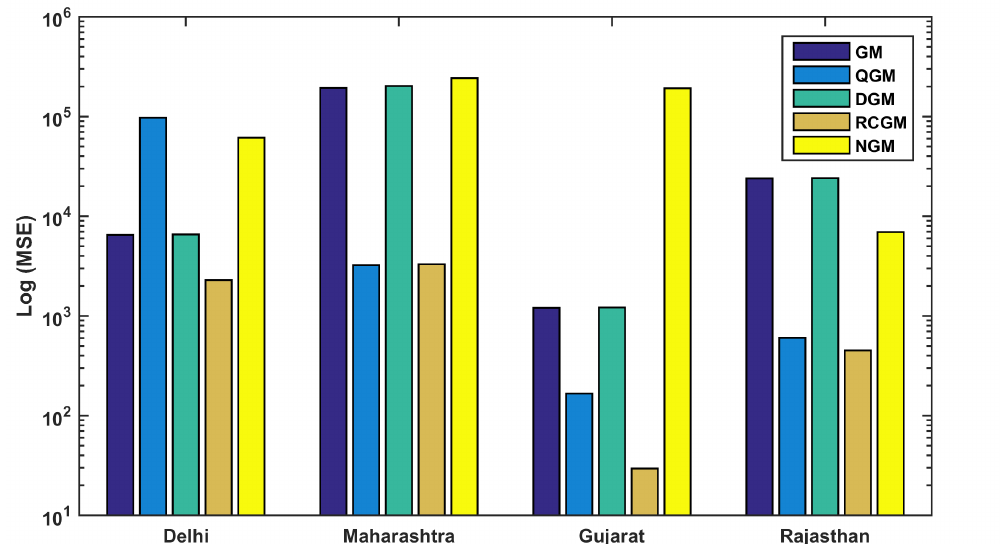
Figure 5. Forecasting Results-MSE for